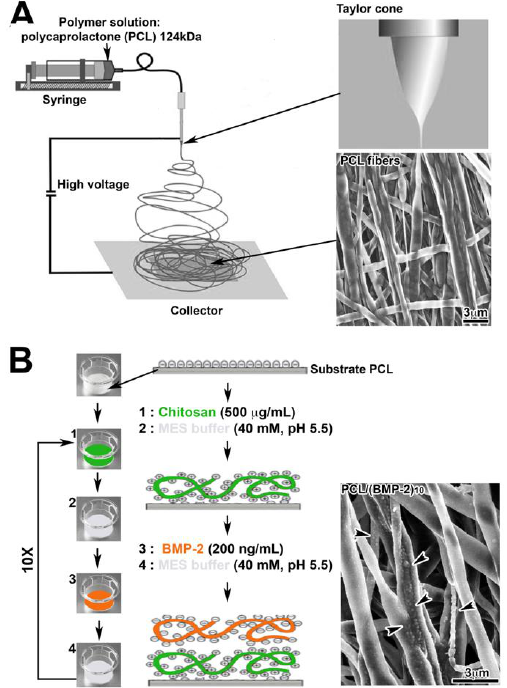
Figure 1. ( A ) Diagram of the electrospinning technique and scanning electron microscopy